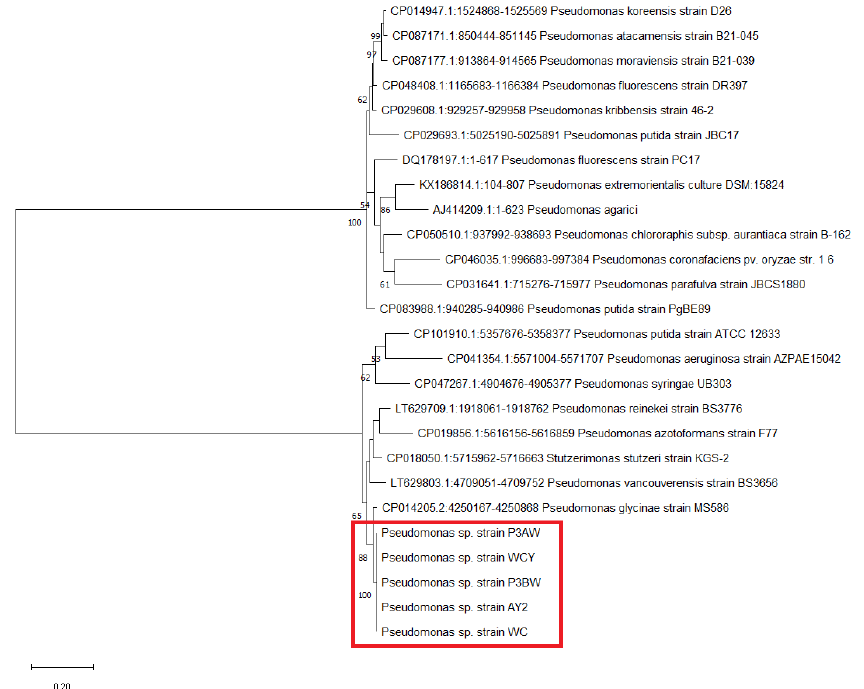
Figure A2. Maximum likelihood phylogenetic tree of Pseudomonas sp. strains based on the carA gene. The number at the branches indicates the percentage of occurrences of that branch over 1000 bootstrap replications, with values under 50% hidden. Pseudomonas sp. Strains from Agave palmeri are circled by the red box.